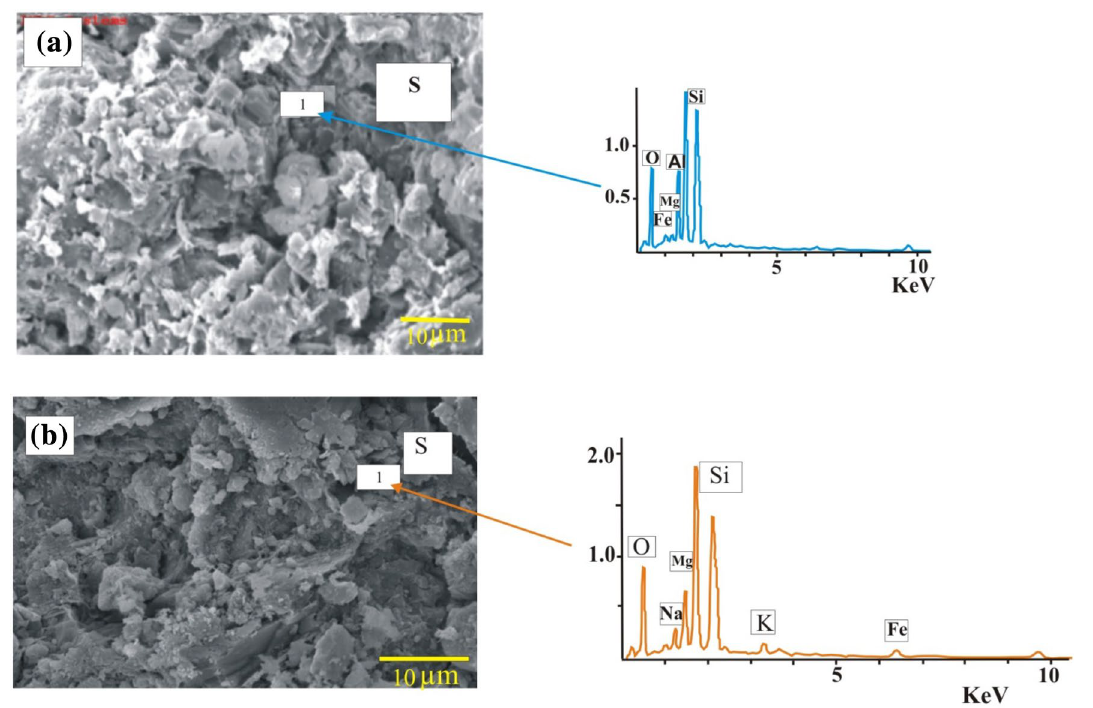
Fig. 8 Representative SEM micrographs and EDS traces for the Kömürlü and Penek Formation sandstones. a Smectite (S) mineral is shown as a flake morphology. Dominant smectite (S) peaks are Mg, Fe, Al, Si, and O elements in the EDS spectrum (a single well, The